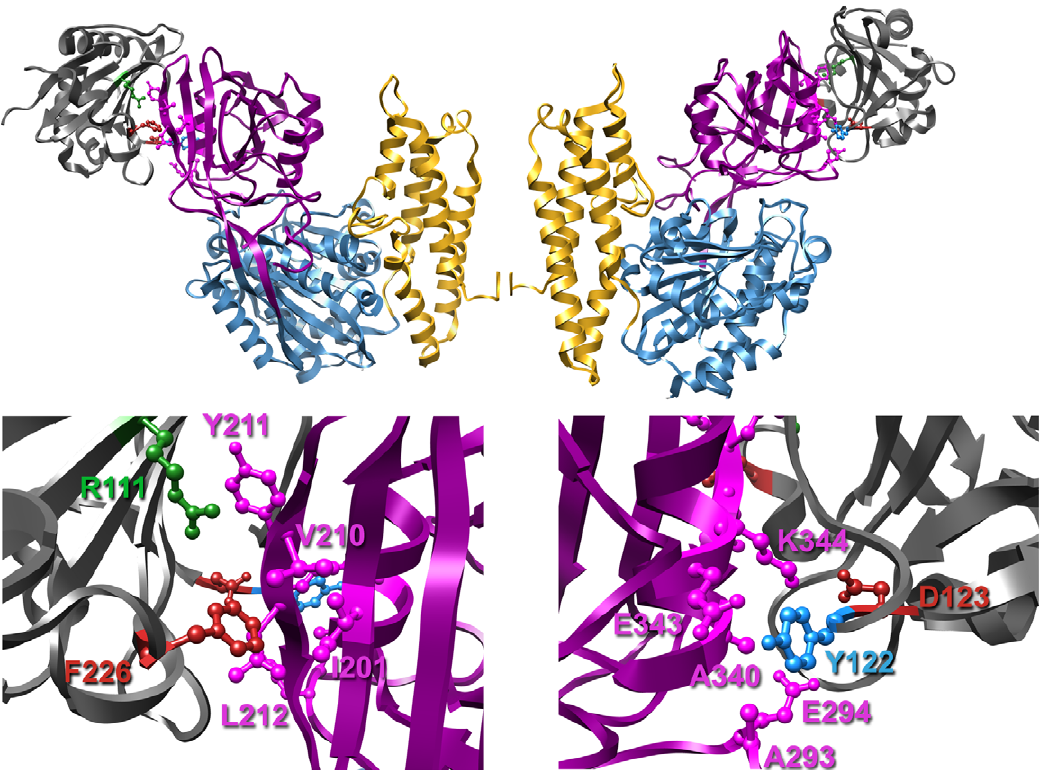
Figure 4. MACV glycoprotein determinants for hTFR1 binding and cell entry. Top panel, structure of the MACV GP1-hTfR1 complex (as described in [25]) with the cell surface orientated to the bottom (PDB ID number: 3KAS). The TfR1 protease-like, helical, and apical domains are colored blue, gold, and magenta, respectively. MACV GP1 is colored in dark grey. Mutated residues are colored as in Fig. 1. Bottom panel, enlargement of the TfR1:MACV GP1 contact sites. MACV residues important for TfR1 binding are labeled and colored as in Fig. 1. TfR1 residues are labeled and colored in magenta.